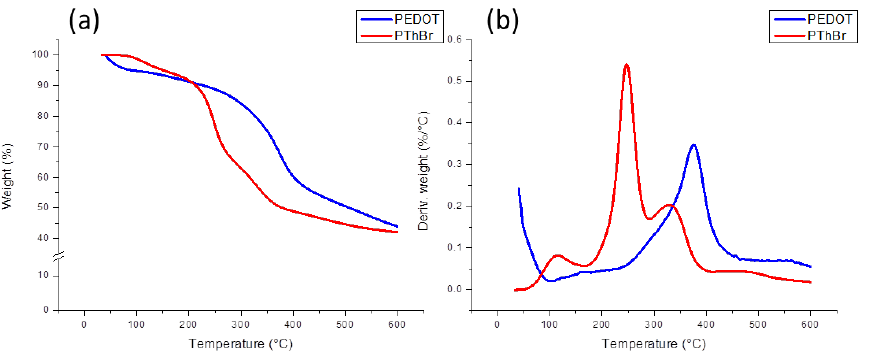
Figure 4. Thermogravimetric analysis of pure poly(3,4-ethylenedioxythiophene) (PEDOT) and PThBr: ( a ) TG curves and ( b ) DTG curves.